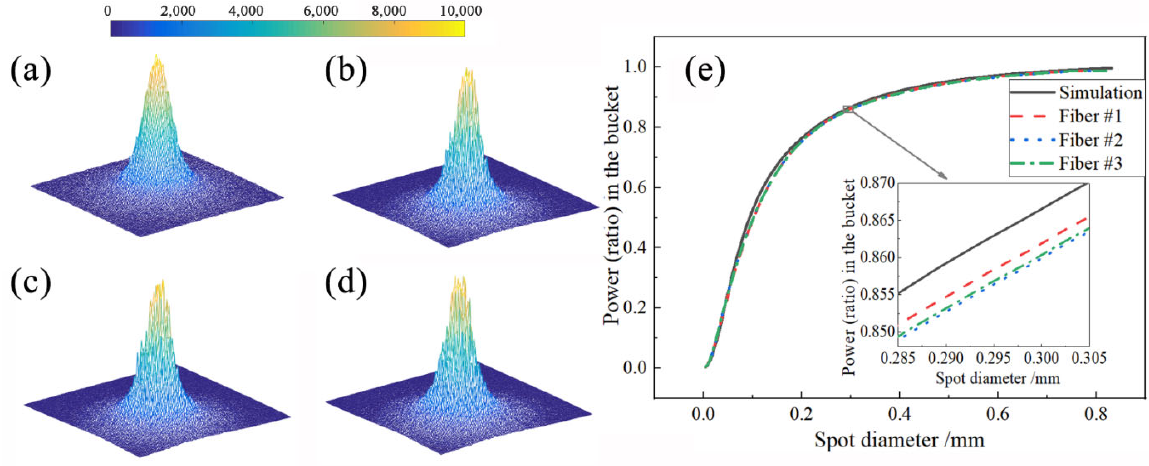
Figure 2. Simulated and experimental results: ( a ) simulated spot; ( b ) experimental spot of fiber #1; ( c ) experimental spot of fiber #2; ( d ) experimental spot of fiber #3; ( e ) PIB curves of four spots.